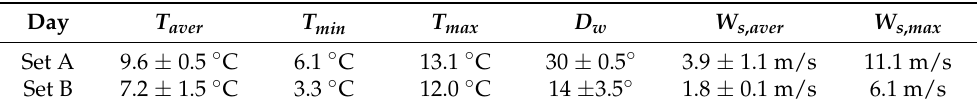
Table 3. Meteorological variables of the reference Sets A and B. Information prepared by the Agencia Estatal de Meteorolog í a of Spain (data collected at the Valdespartera Station, Zaragoza Spain, 23 December 2020).